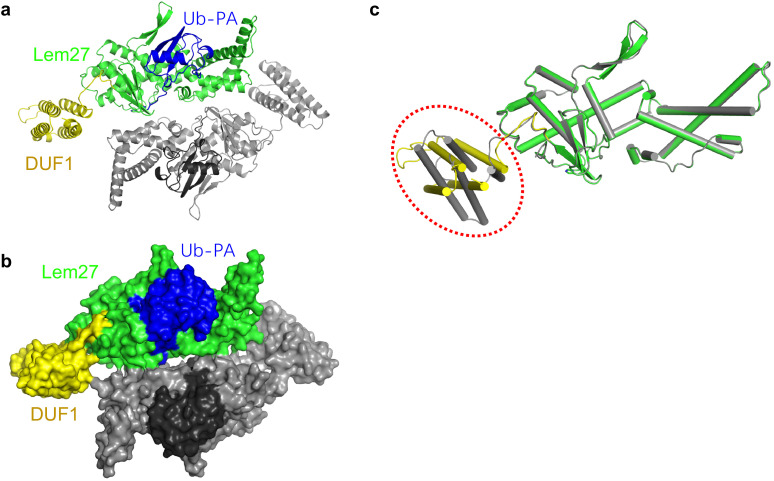
The overall structure of the Lem271-417 -ubiquitin complex in one asymmetric unit.(a–b) The ribbon mode (a) and surface mode (b) of the structure in one asymmetric unit. (c) Superimposition of the two Lem271-417 in one asymmetric cell, an approximate 35o rotation of the DUF1 domain is circled.